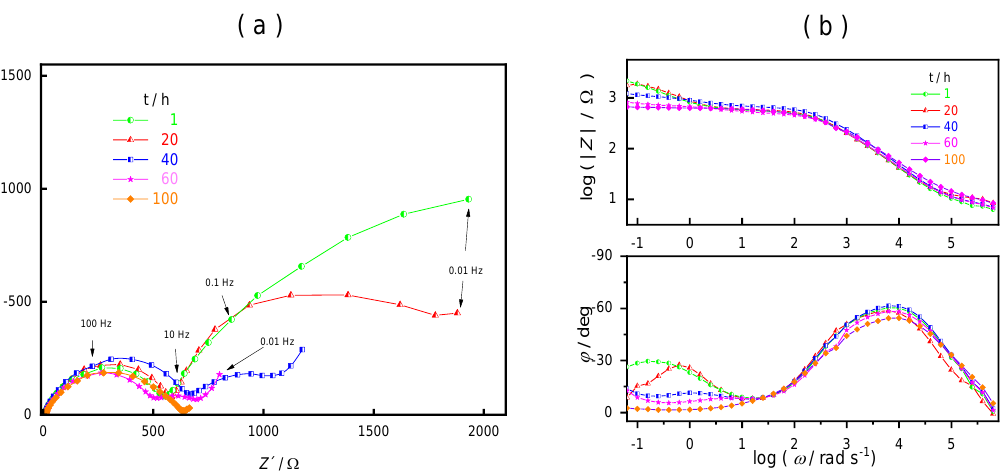
Figure 6. In situ GEIS impedance spectra for HCSi20 electrode in ( a ) Nyquist plot, ( b ) Bode plot. From the dependencies shown, it is evident that only the impedance spectrum meas- ured after one hour shows a low-frequency (LF) semicircuit connected with an additional